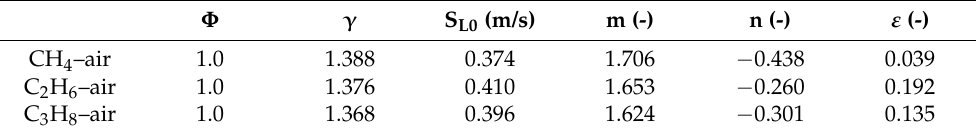
Figure 5. LBV for ( a ) ethane–air and ( b ) propane–air calculated with Cantera code–comparison with experimental data [31–36]. Table 2. Parameters for stoichiometric hydrocarbon–air mixtures calculated with Cantera code.